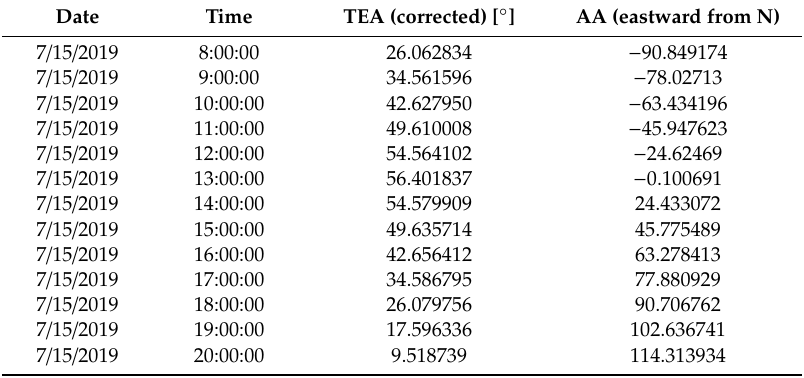
Table 5. Topocentric elevation angle (TEA) (corrected) и Azimuth angle (AA) (eastward from N) in Chelyabinsk on July 15, 2019 from 8:00 AM to 8:00 PM according to NREL MIDC SPA.